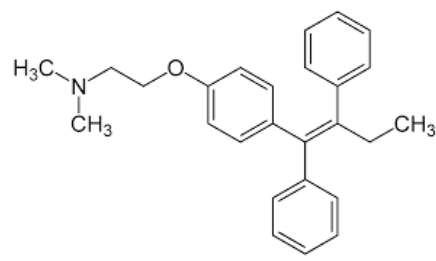
Figure 35. Chemical structure of tamoxifen. Formula: C 26 H 29 NO.